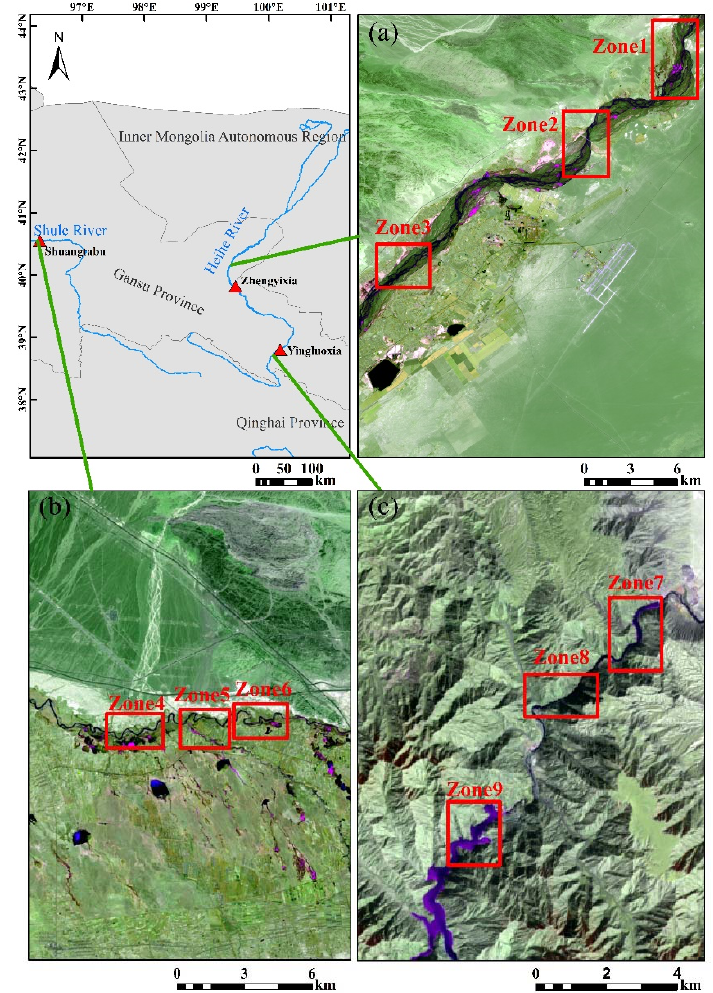
Figure 1. Three study areas ( a ) Zhengyixia reach of the Heihe River, ( b ) Shuangtabu reach of the Shule River, ( c ) Yingluoxia reach of the Heihe River, and nine demonstration zones (in red rectangles).